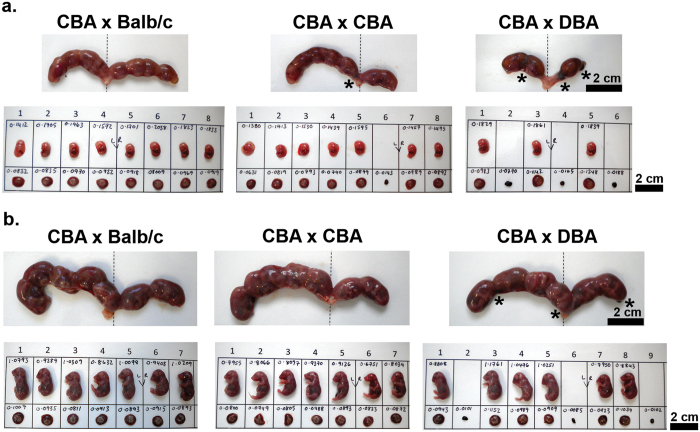
Macroscopic pregnancy outcomes of murine CBA/CaH × DBA/2J pregnancies.Representative photographs of gravid uteri harvested from CBA/CaH × Balb/c, CBA/CaH × CBA/CaH and CBA/CaH × DBA/2J pregnancies at (a) 14.5 dpc (N = 20 dams per strain) and (b) 18.5 dpc (N = 30 dams per strain). Fetuses and placentae were excised, measured, weighed and photographed. Weights of fetuses, placentae and resorptions are indicated in grams. Asteri denote resorption sites indicating embryonic/fetal mortality.